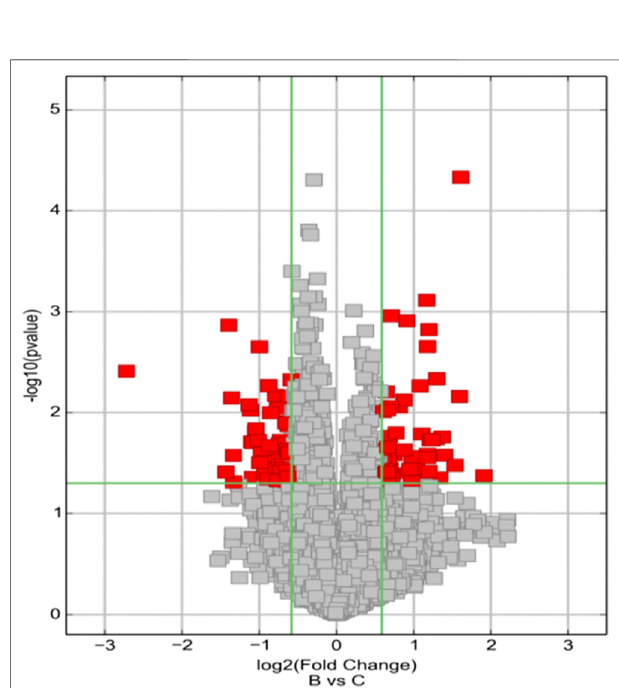
FIGURE 1 | The constituent of dysregulated circRNAs.